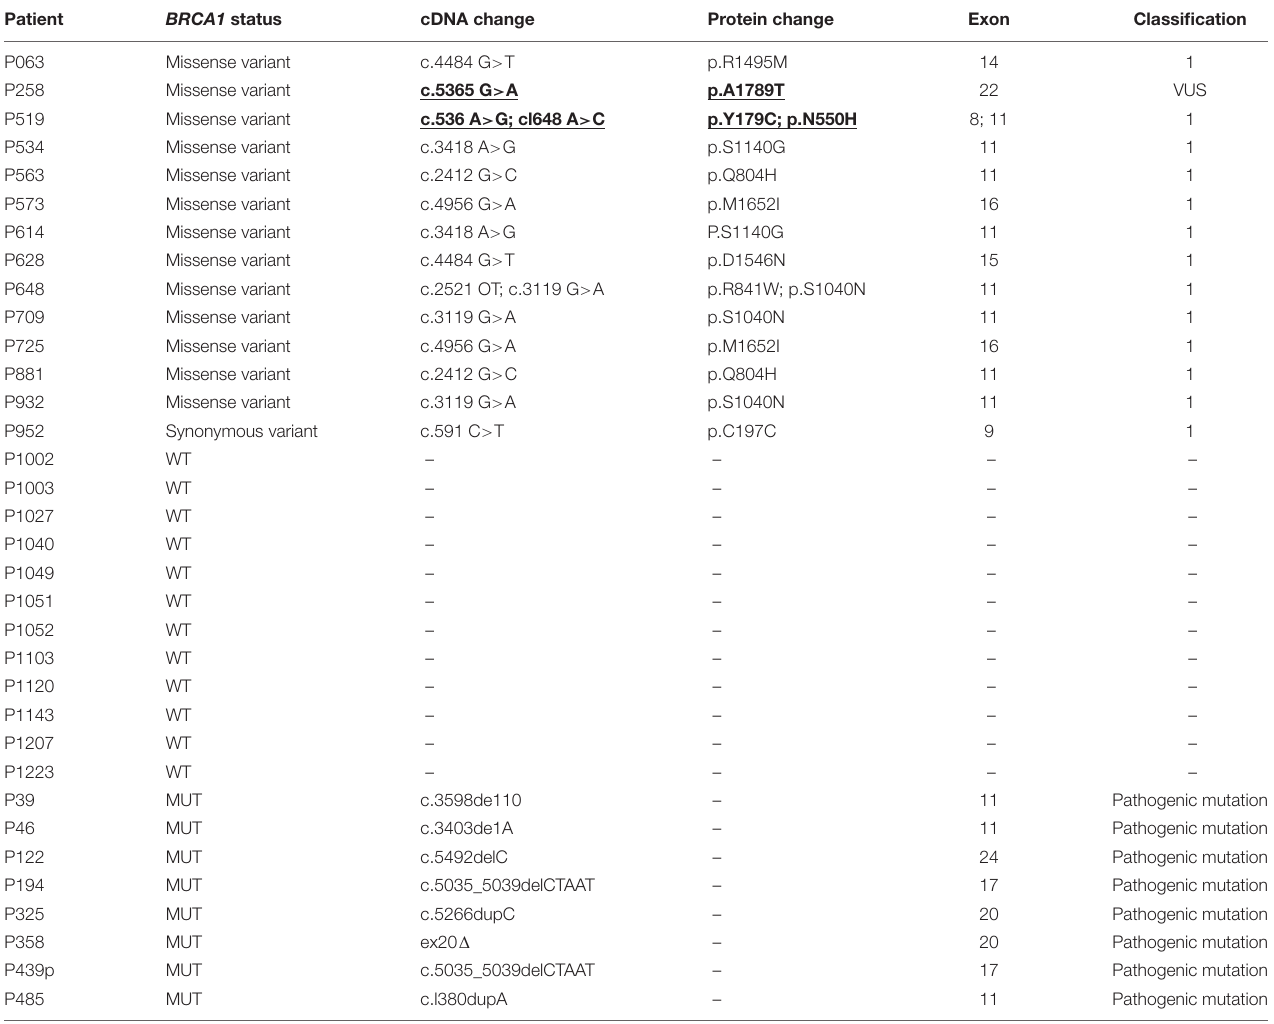
TABLE 1 | BRCA1 status of